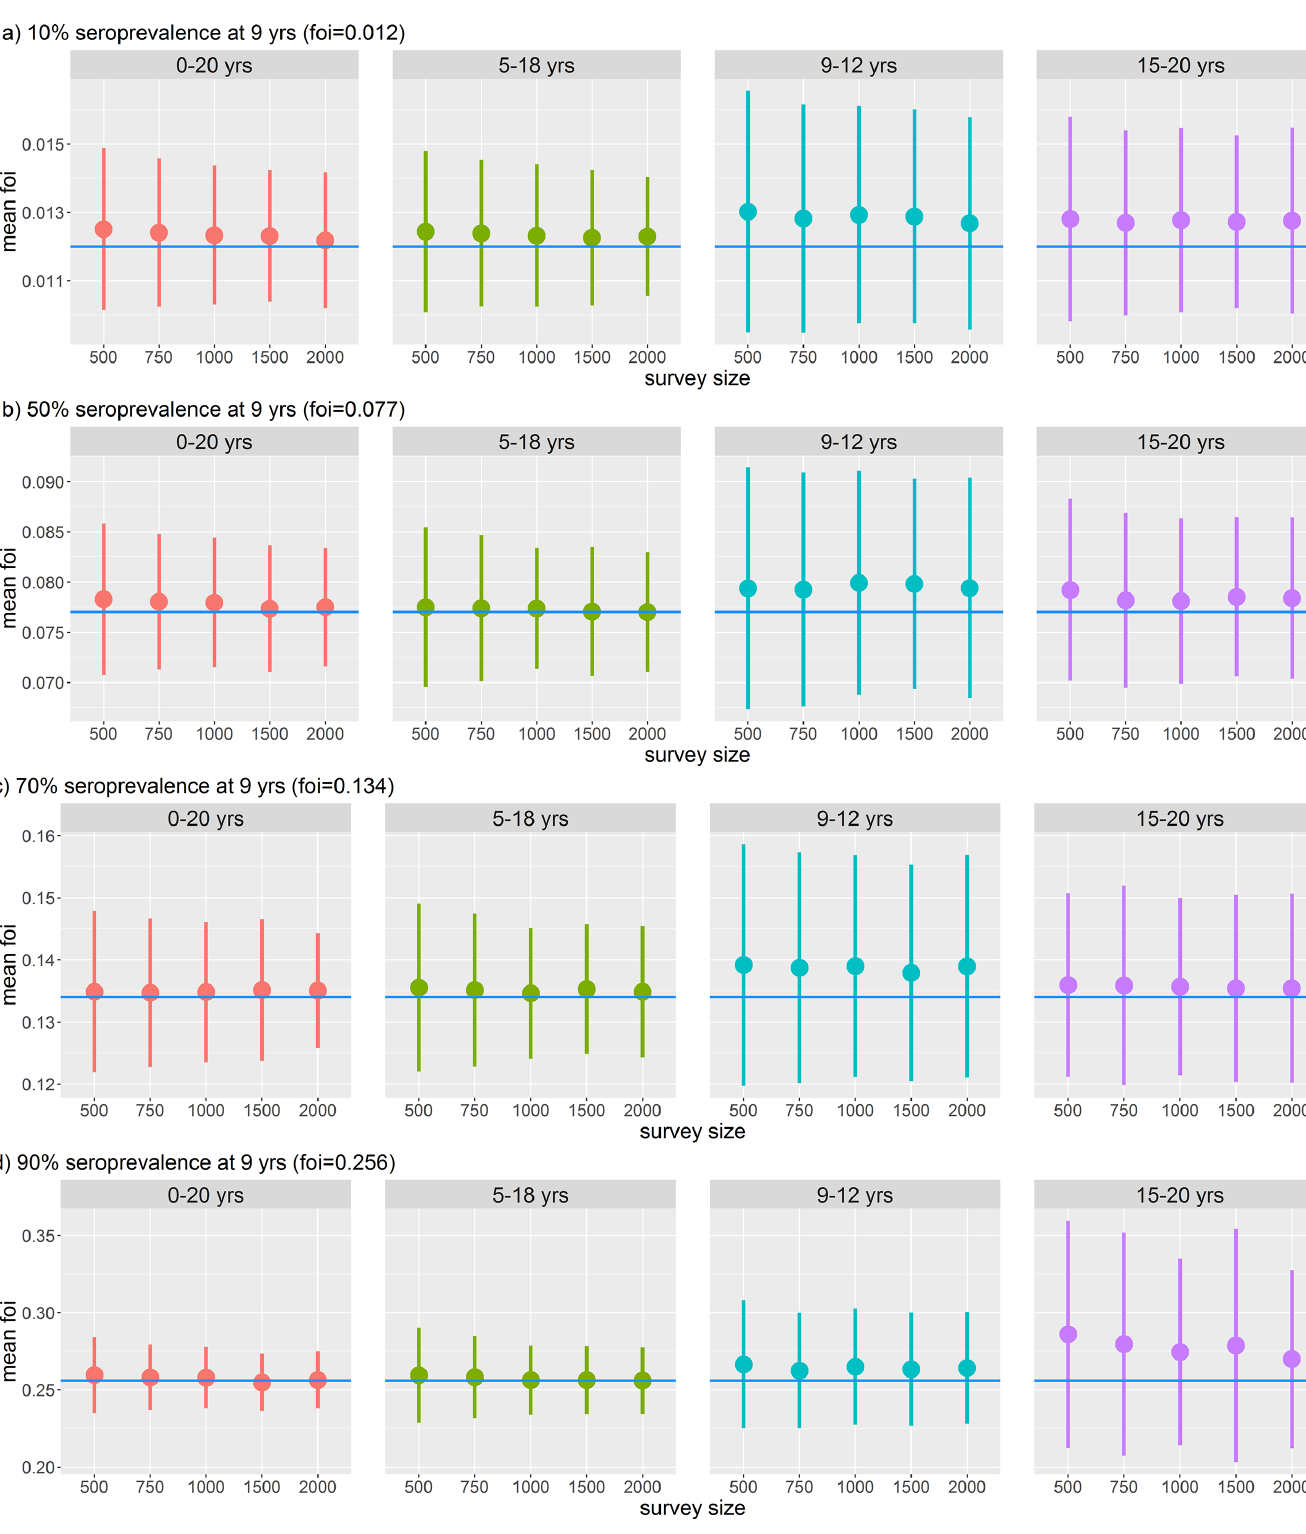
Fig 3. Dengue force of infection estimated from different age ranges and survey sizes at different transmission settings assuming a beta-binomial distribution and a perfect test is used (100% sensitivity and specificity). A) Very low transmission setting (10% seroprevalence at 9 years), B) medium transmission setting (50% seroprevalence at 9 years), C) high transmission setting (70% seroprevalence at 9 years), and D) very high transmission setting (90% seroprevalence at 9 years). The point is the mean of the mean posterior estimates from 100 simulations and the line the standard deviation. The blue line shows the true value of the force of infection. https://doi.org/10.1371/journal.pone.0199450.g003 PLOS ONE | https://doi.org/10.1371/journal.pone.0199450 June 26,